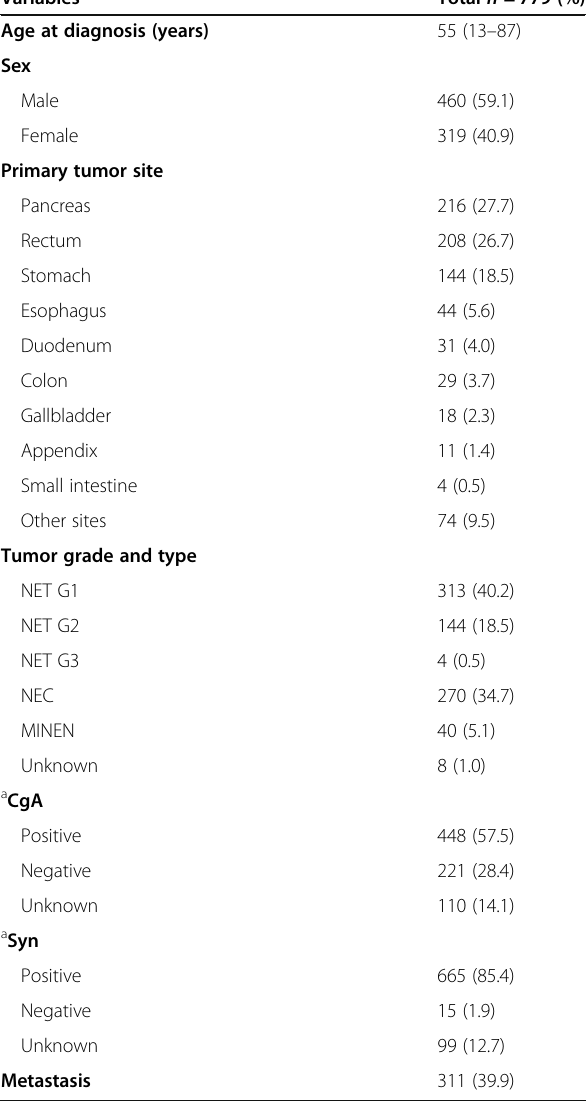
Table 1 Clinical characteristics in 779 patients with GEP-NENs